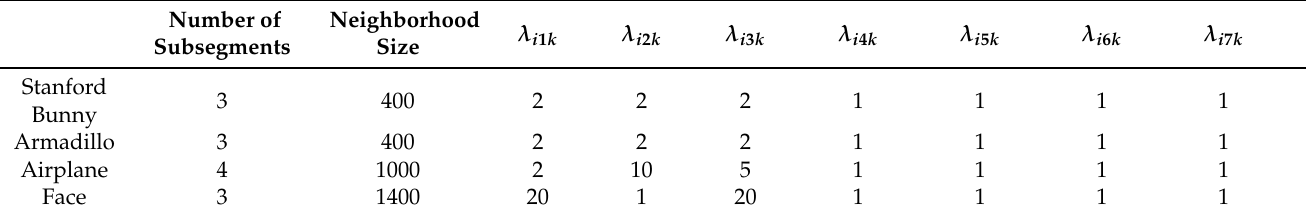
Table 1. Parameters of λ -ICP algorithm for the congruent